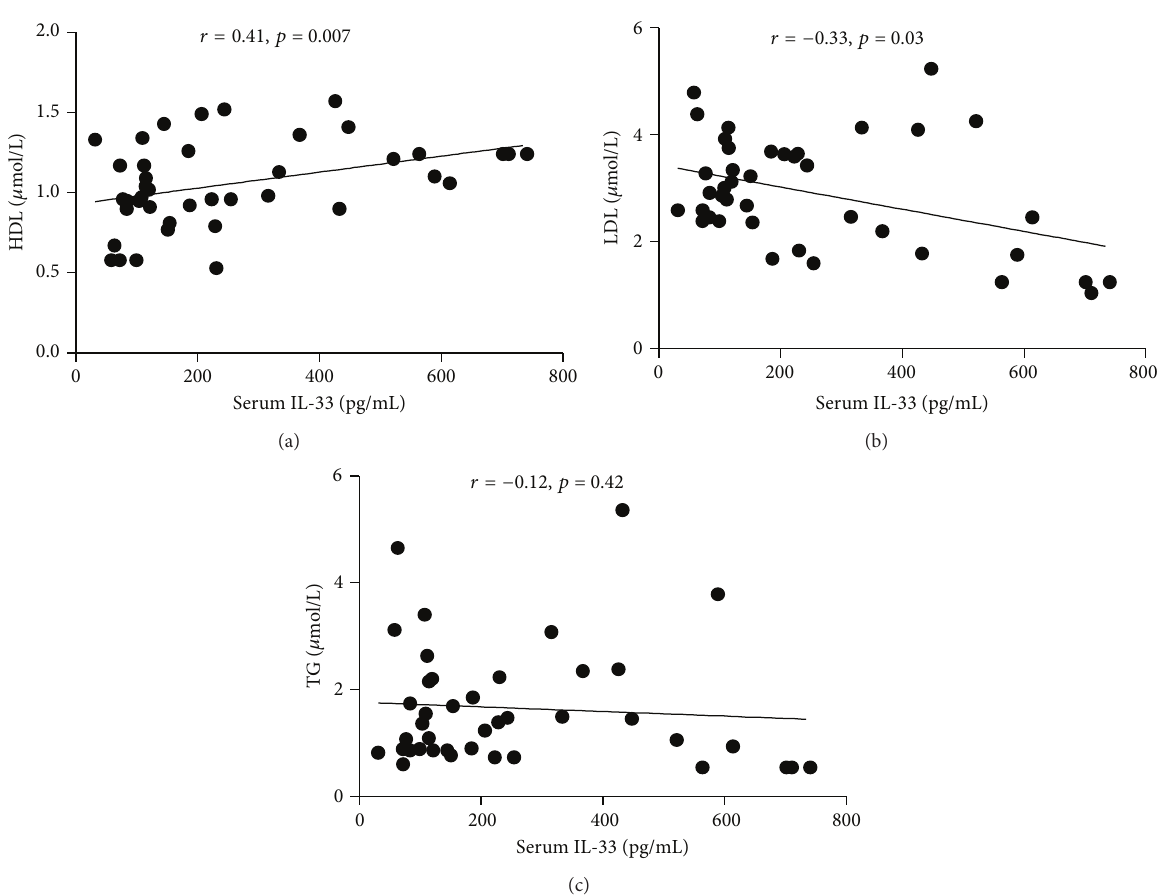
Figure 4: The correlation of IL-33 with lipoprotein in gout patients. (a) Serum IL-33 was positively correlated with HDL in gout patients ( 𝑟 = 0.41 , 𝑝 = 0.007 ). (b, c) Serum IL-33 level was negatively correlated with LDL ( 𝑟 = −0.33 , 𝑝 = 0.03 ) and TG ( 𝑟 = −0.12 , 𝑝 = 0.42 ) in gout patients. Serum IL-33 level was not detected to correlate with TG from gout patients. Spearman correlation analysis was